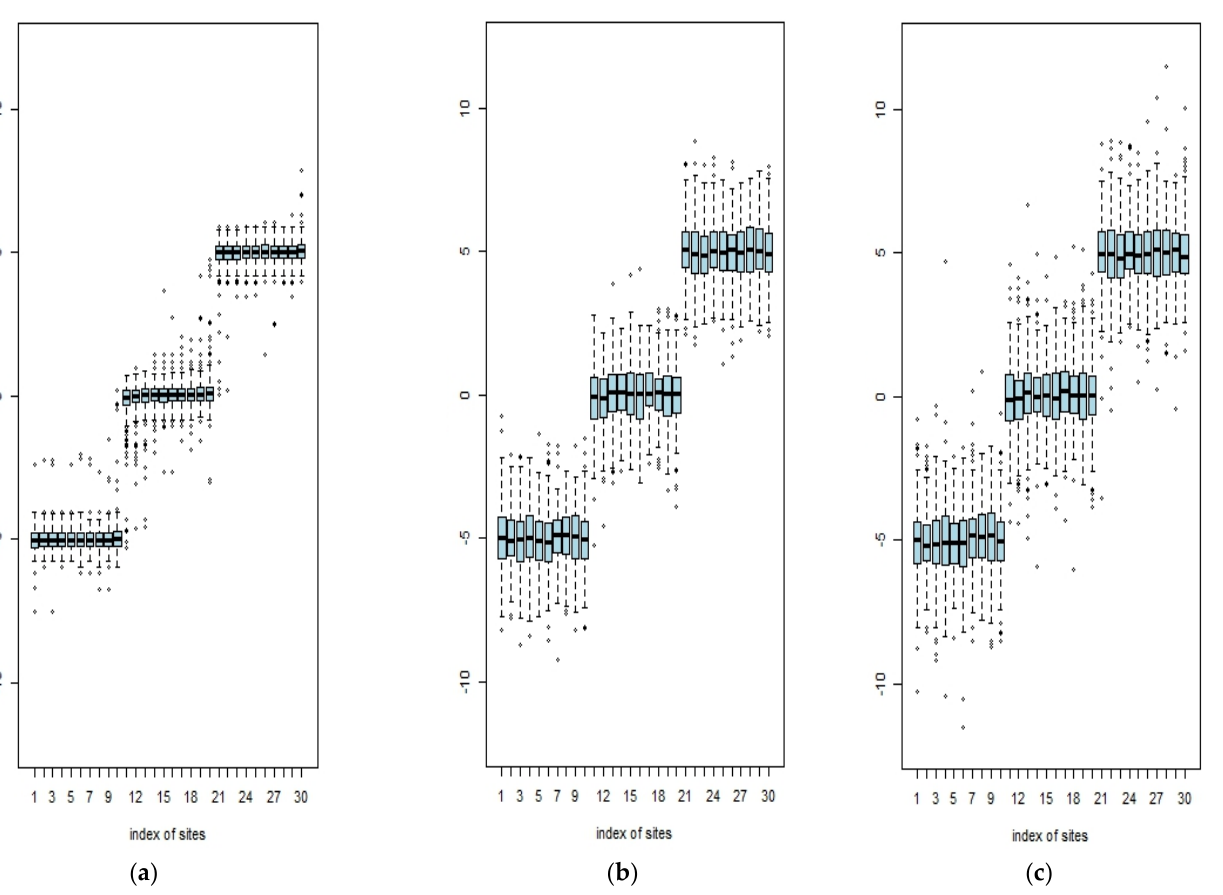
Figure 3. Estimated coefficients of the proposed method ( a ), rLSE ( b ) and rLAD ( c ) in simulation 1.